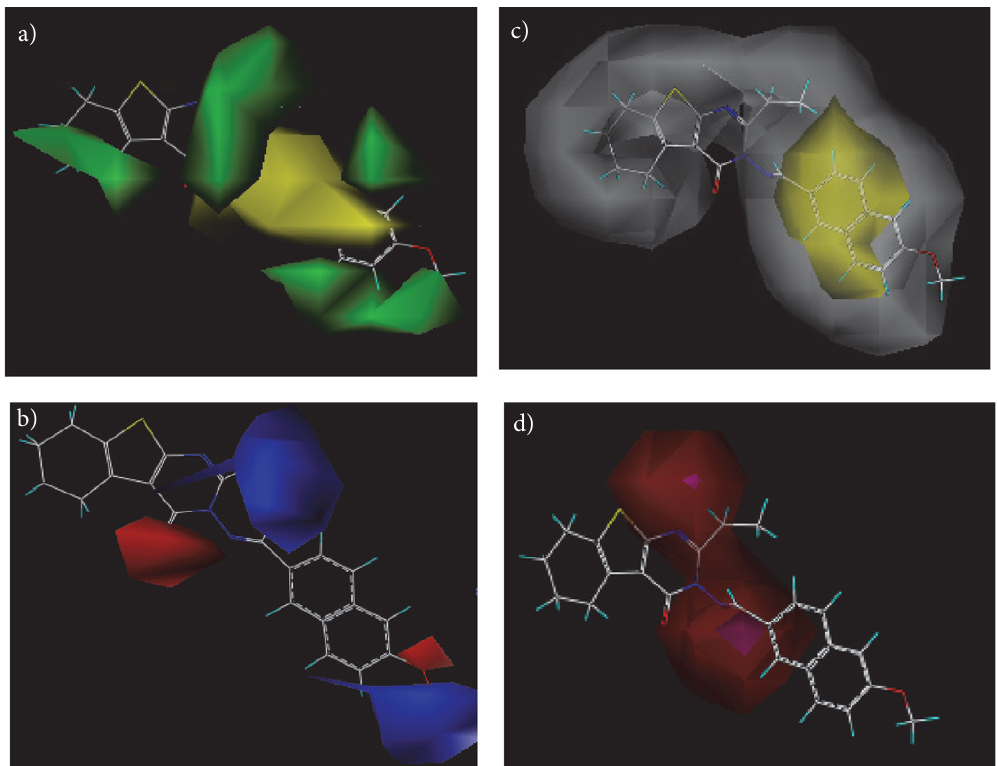
Fig. 5. CoMFA and CoMSIA STDEV*COEFF contour maps: a) steric, b) electrostatic, c) Hydrophobic, d) hydrogen-bond acceptor and hydro- gen-bond donor fields; based on the most active compound